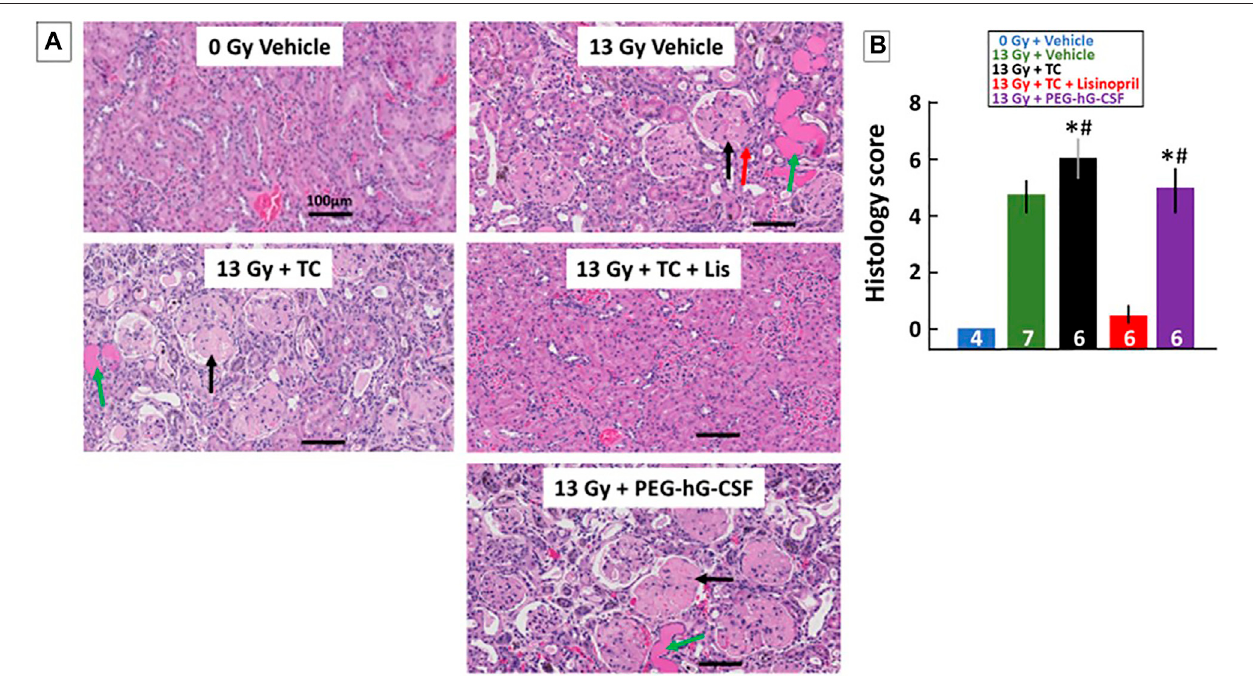
FIGURE8| Kidneyinjurymitigatedbylisinoprilafter13 Gyleg-outPBI.Representativehistologicalsectionsofkidneysforeachtreatmentgroup (A) wereharvested attheterminationofthestudy(120-days)after13 Gyleg-outPBI, fi xedandstainedwithH&E.IrradiatedratsgiventhevehicleorPEG-hG-CSFshowedincreasedprotein casts (green arrow), glomerular sclerosis (black arrow) and glomerular mesangiolysis (red arrow) compared to non-irradiated rats. The irradiated and triple combination (TC) group showed increased protein casts and glomerular sclerosis while the addition of lisinopril mitigated these histological changes. Graphical representations oftheH&E-stainedkidneysectionsareshownin (B) asacompositehistologicalscore.Renalinjurywasincreasedwithirradiation,theasterisks(*)represents p < 0.05as compared to non-irradiated controls while the pound symbol (#) represents p < 0.05 as compared to the irradiated + TC + lisinopril. Numbers in the bars represent N in each group and bars are means with standard